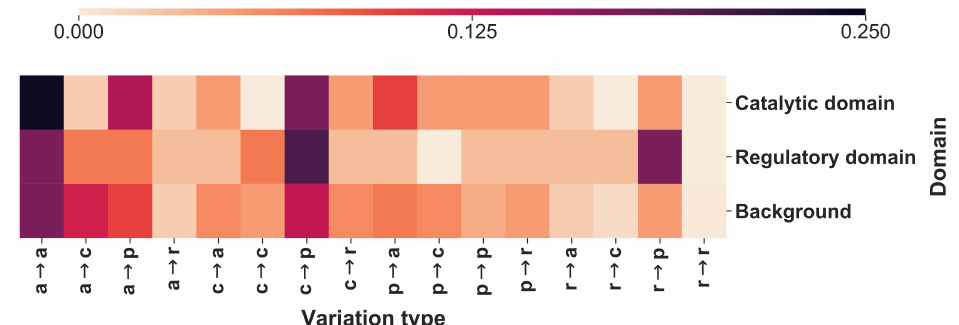
Figure 2. The heatmap reporting the frequency of each variation type as observed within the catalytic and the regulatory domains. The background distribution has been computed considering 22,763 pathogenic variations from Humsavar in 2513 proteins. In variation types, labels are as follows: a, apolar; c, charged; p, polar; and r, aromatic (for details see text). Differences between Catalytic and Regulatory sites are significant at 10% when a Chi-square test is applied after adding pseudocounts (with value 0.5) for